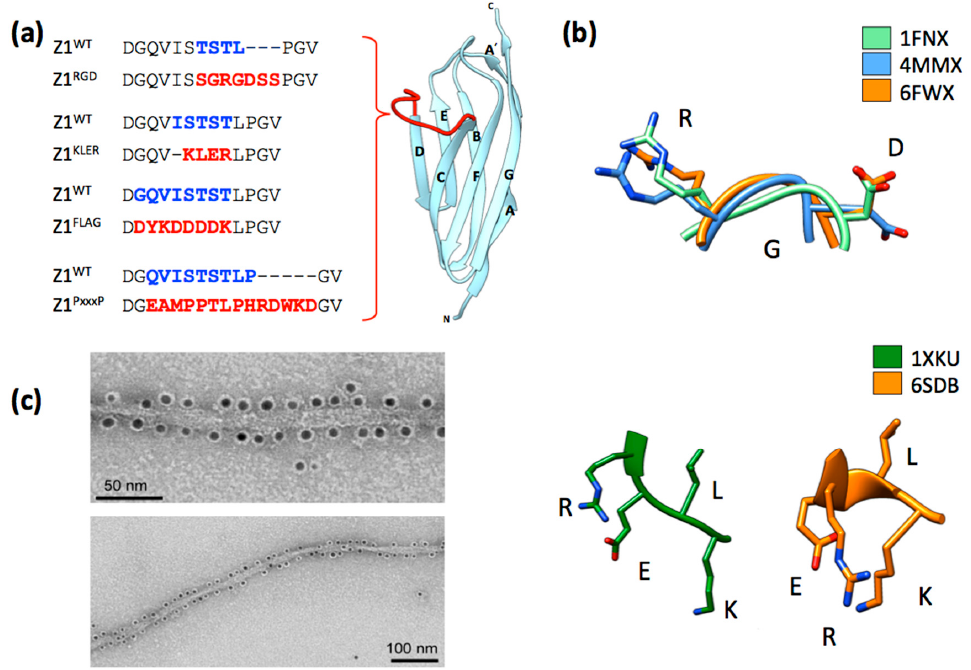
Figure 3. Exogenous peptide display on ZT components. ( a ) Overview of sequences grafted to date onto the CD loop of Z1. The crystal structure of Z1 (extracted from PDB 2A38) is shown and its CD loop is highlighted in red. For each grafted variant, native residues removed from Z1 are indicated in blue and the introduced exogenous residues in red. In the largest substitution, 14 new residues